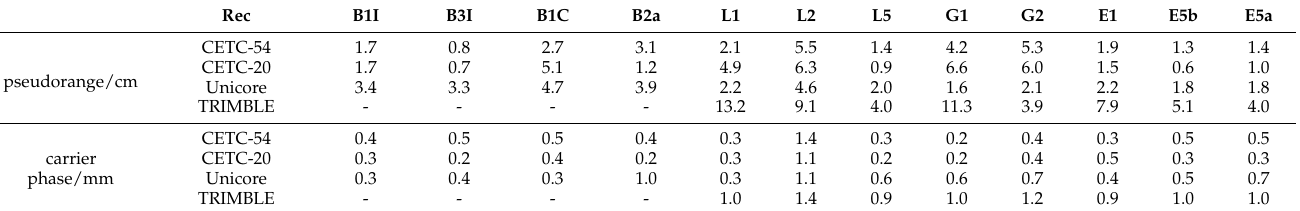
Table 6. Zero baseline pseudorange (a, unit: cm) and carrier-phase (b, unit: mm) noise. Rec